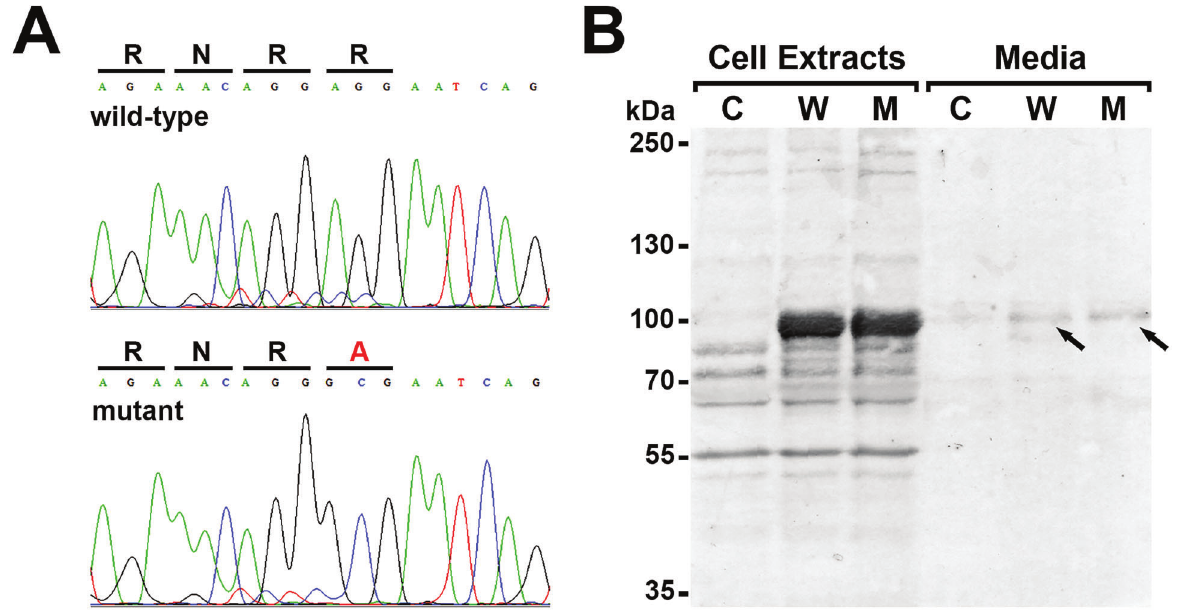
Figure 1. Veri fi cation of Sema3C R745A mutant expression and secretion. A , Sequencing results of the putative furin cleavage site 742 RNRR 745 of the wild-type Sema3C and R745A mutant. B , Sema3C and R745A mutant protein expression in transfected 293FT cell extracts and cell medium. C: control (transfected with empty vector cells); W: wild-type Sema3C; M: mutant Sema3C (R745A). Black arrows indicate Sema3C and R745A mutant proteins of 85.2 kDa in